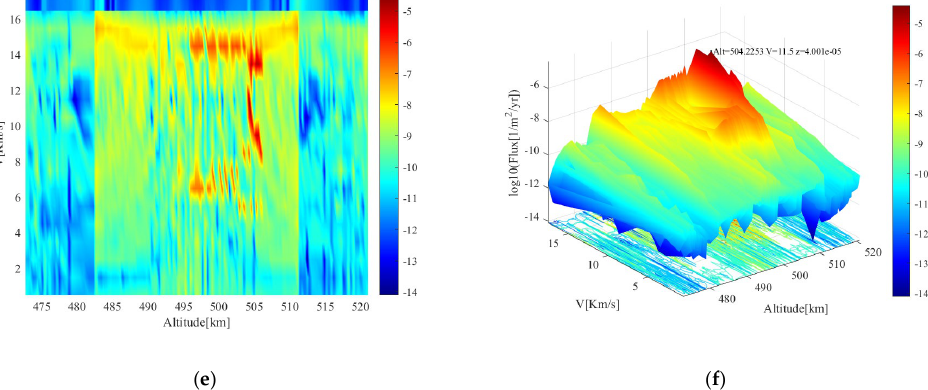
Figure 5. Orbital object flux and velocity flux variation. ( a , b ) Before and after Alt-V fluxes of GAOFEN satellites; ( c , d ) Before and after Alt-V fluxes of CORVUS BC5 satellites; ( e , f ) Before and after Alt-V fluxes of YAOGAN-35C satellites.